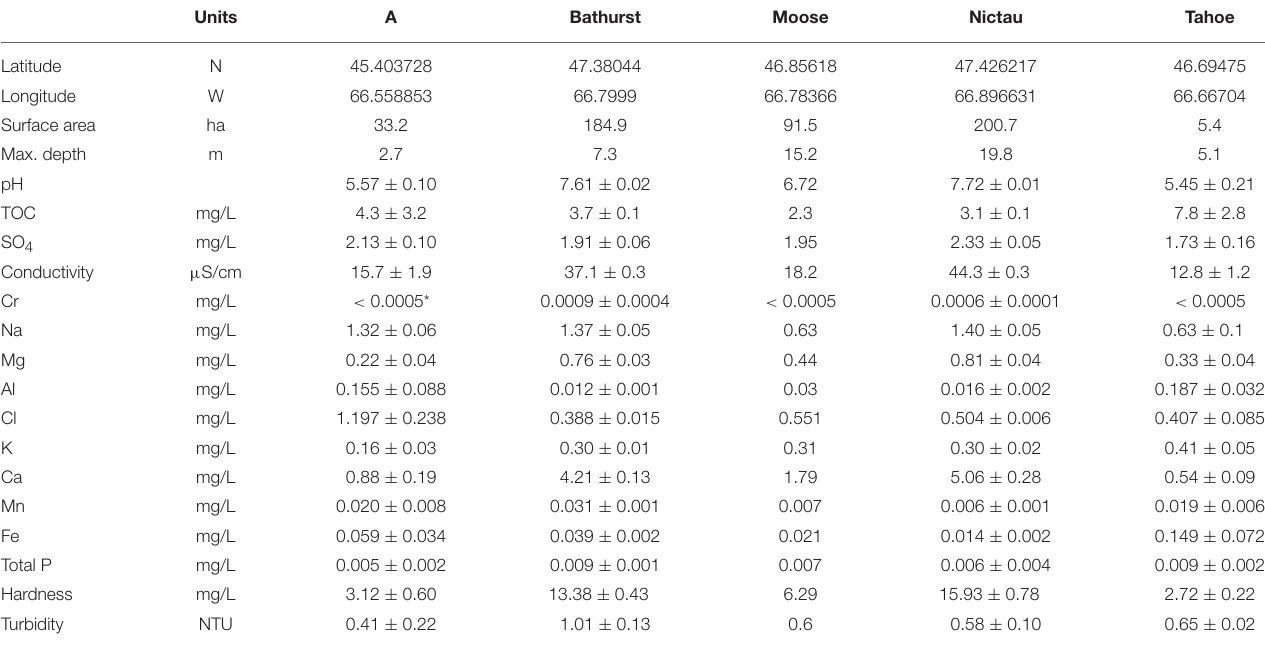
TABLE 1 | Physical and chemical ( n = 3 or 4 for all lakes but Moose) characteristics of A, Bathurst, Moose, Nictau, and Tahoe lakes in New Brunswick, Canada.